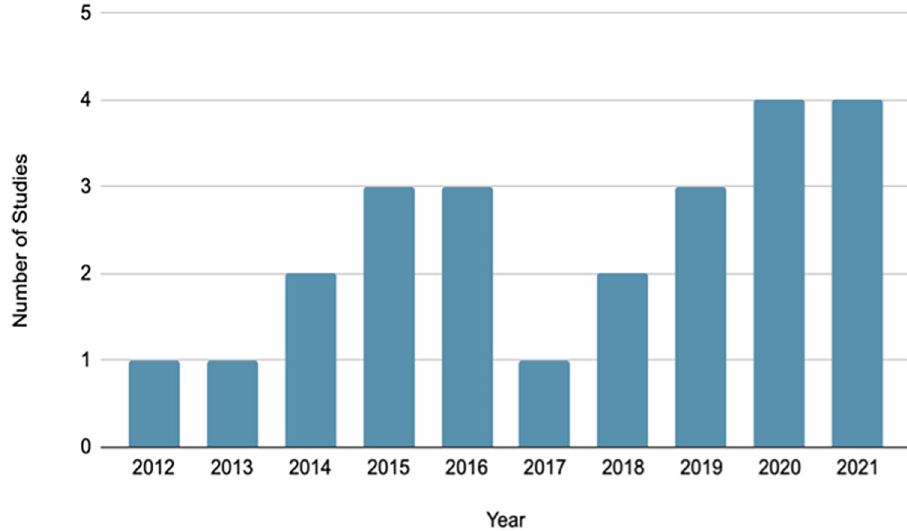
Fig 2. Distribution of articles by year of